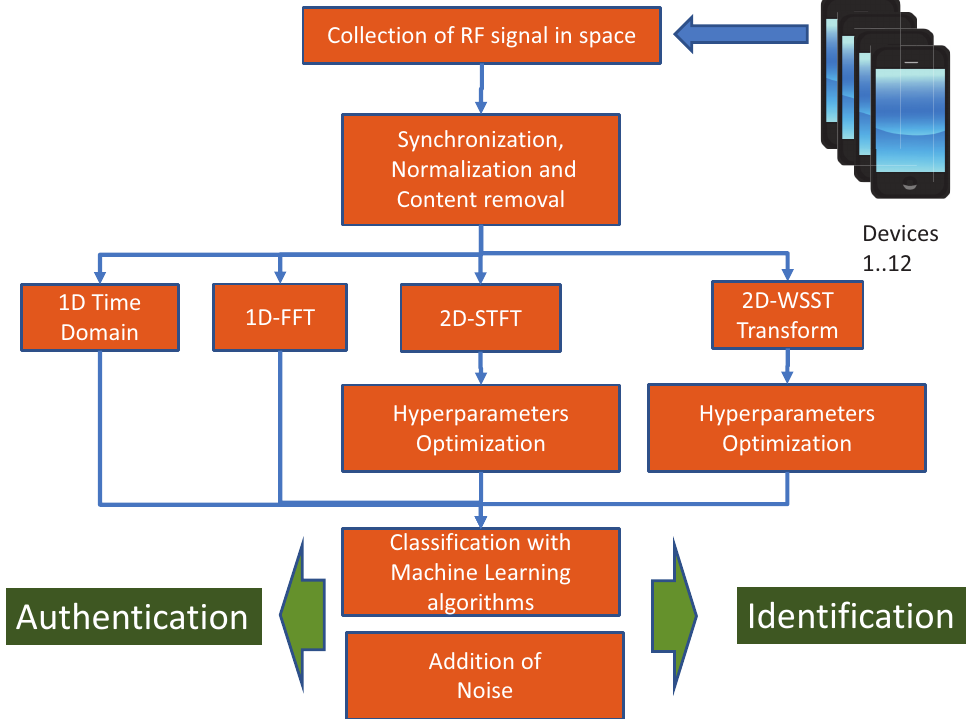
Figure 1. Overall methodology used in this paper for the identification and authentication of the wireless